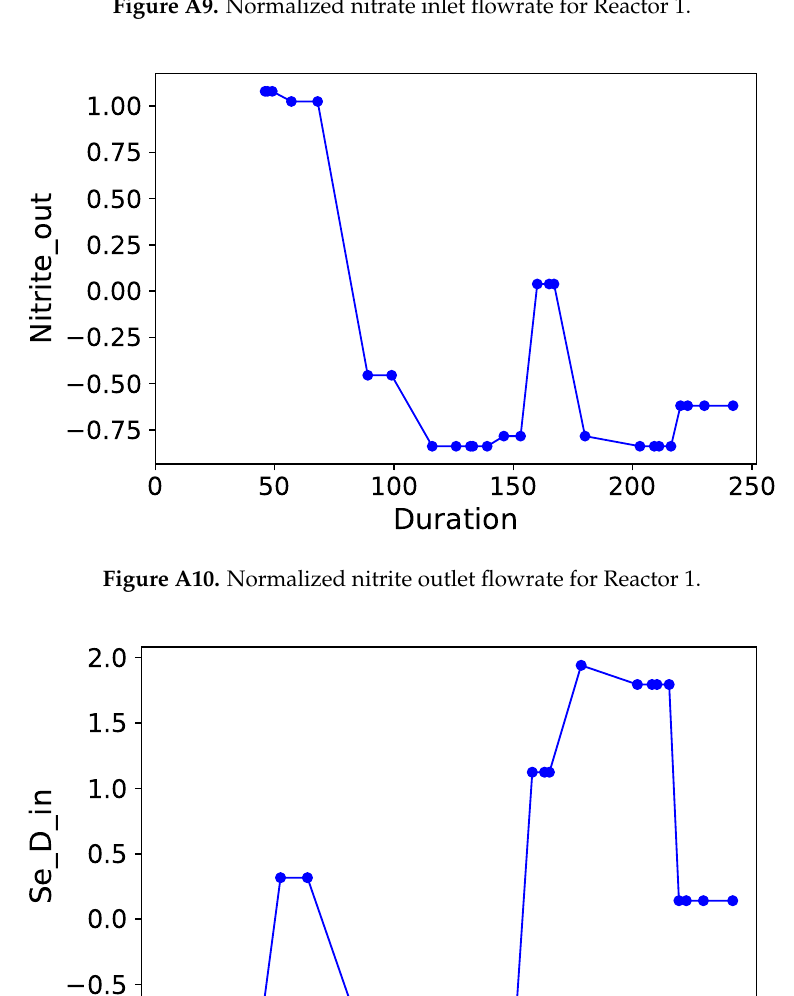
Figure A9. Normalized nitrate inlet flowrate for Reactor 1.